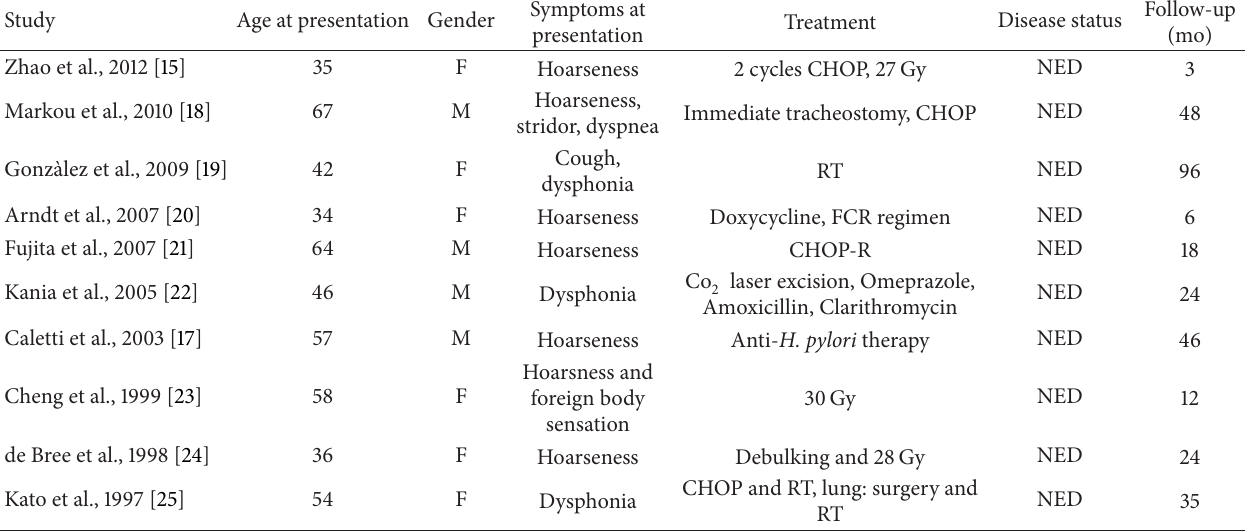
Symptoms at Treatment Disease status presentation